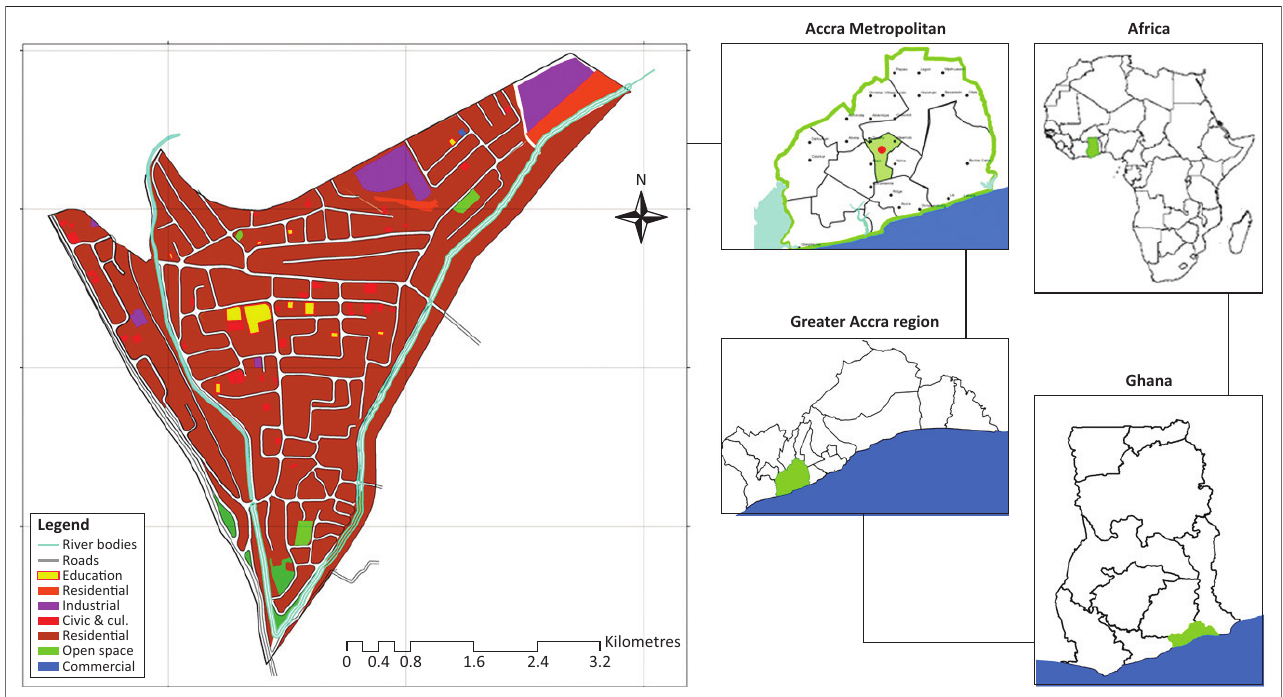
FIGURE 3: Map of Alajo showing the various land uses.